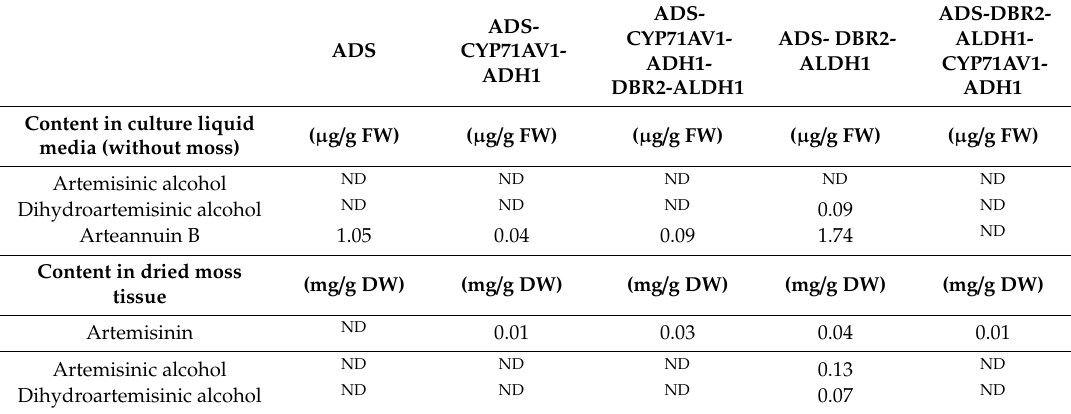
Table 1. Quantification of artemisinin, artemisinin intermediates and arteannuin B produced in transgenic Physcomitrella patens and the moss culture liquid media (from 3 weeks moss culture, average of two cultures). The content in the liquid media represents the amount of molecules that have been excreted from the moss